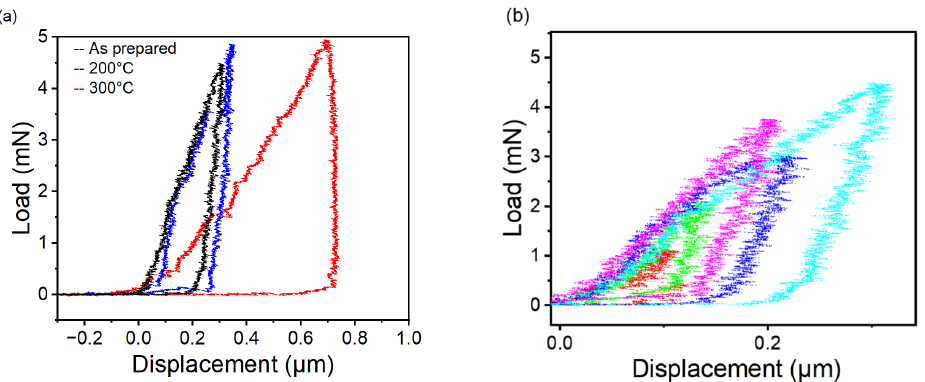
Figure 4. ( a ) Load vs. displacement curves at an F = 5 mN maximum load for the amorphous, 200 ◦ C, and 300 ◦ C annealed MoO 3 thin-film samples; ( b ) load vs. displacement curve for five indentations for the as-prepared sample.